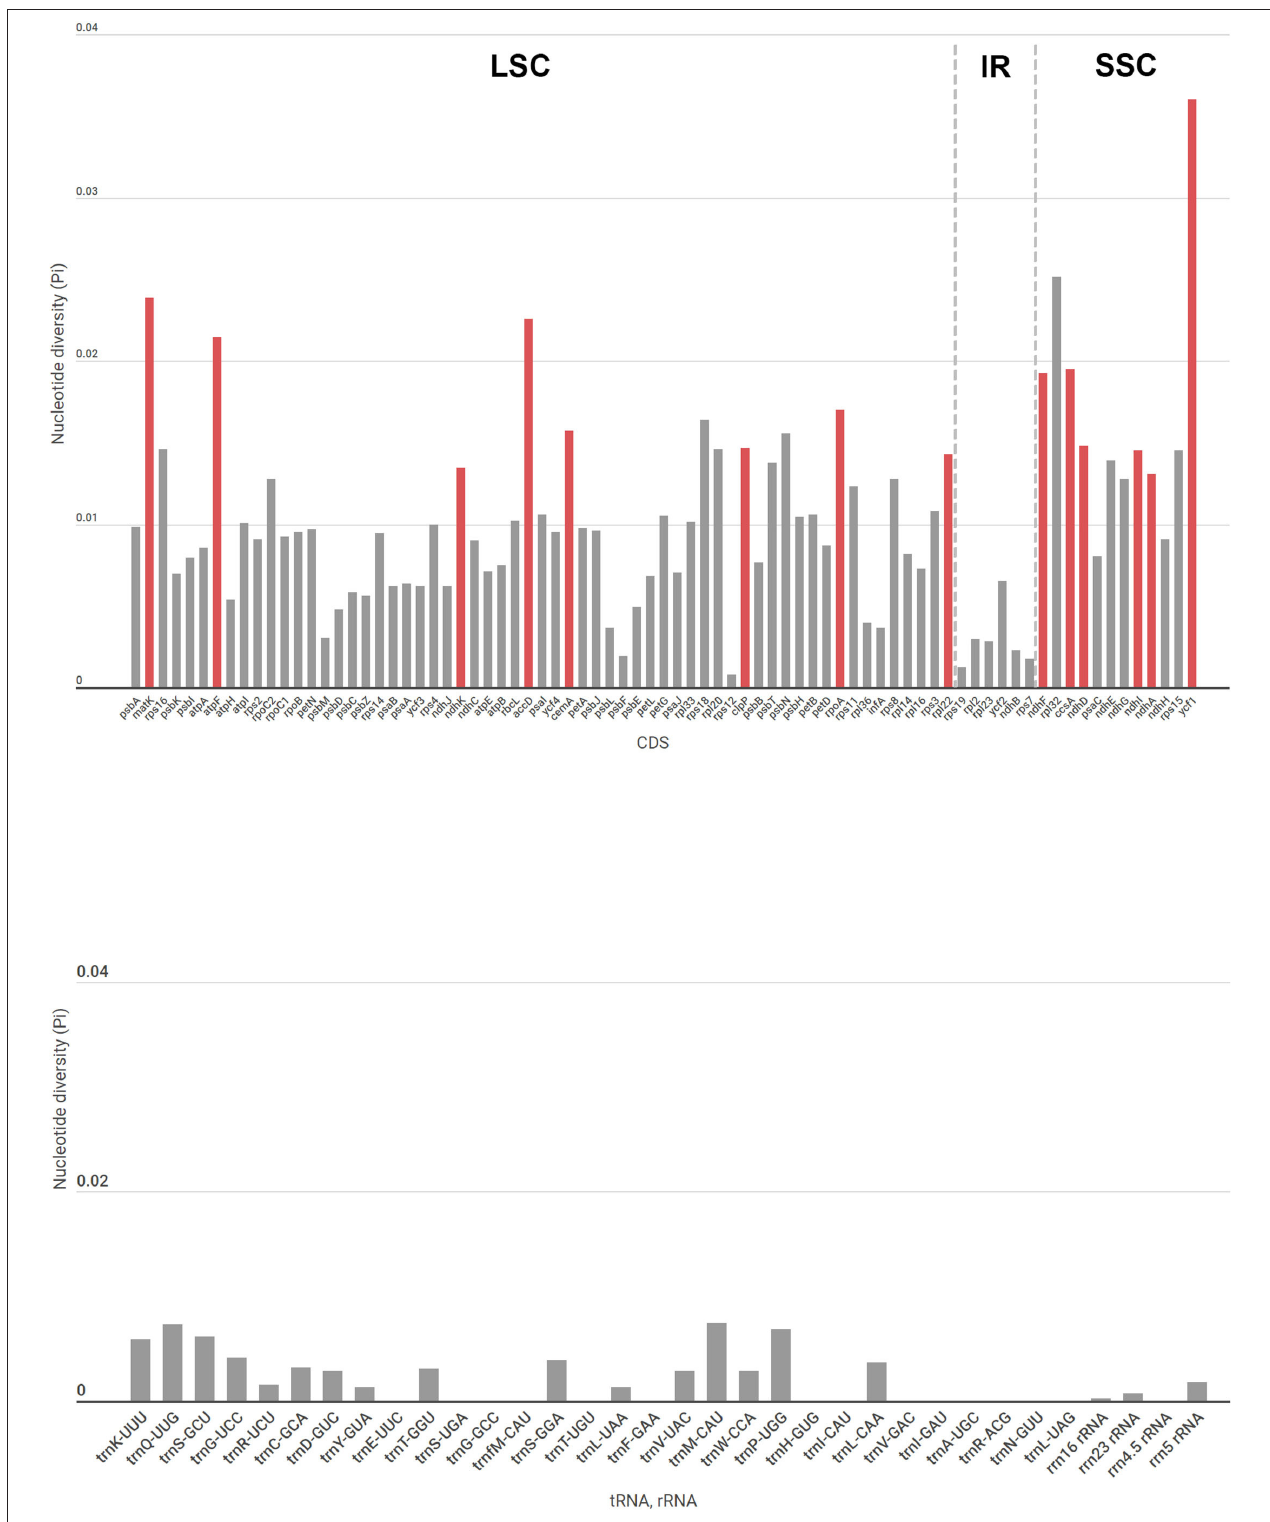
FIGURE 2 | Nucleotide diversity (Pi) values in protein-coding genes, tRNA, and rRNA in 18 Goodyera species. The dashed lines are the borders of the LSC, IR, and SSC regions. The red bars indicate phylogenetically informative genes with Pi > 0.013 and over 500 bp length in our study.